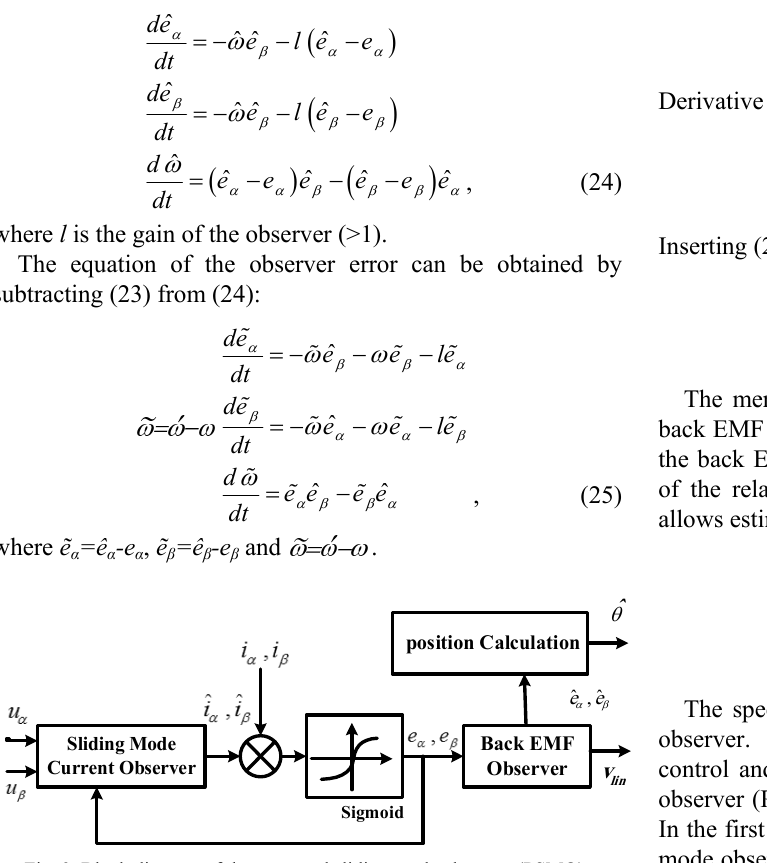
Fig. 3. Block diagram of the purposed sliding mode observer